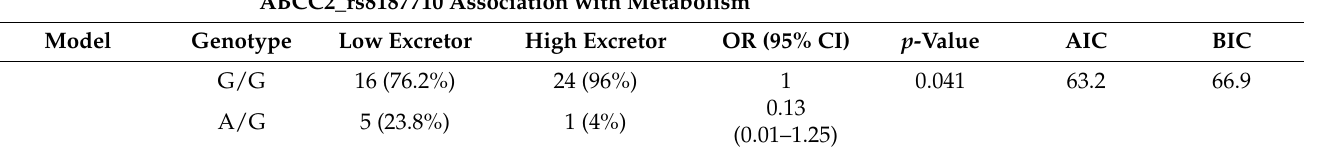
Figure 1. Total phase II flavanone metabolite concentrations in urine depending on genotypes of ABCC2_rs8187710 polymorphism. Bars in the box show the first quartile, the third quartile and median and whisker charts represent the minimum to maximum values. Table 4. Analysis of association of ABCC2_rs8187710 polymorphism with the excretion of phase II flavanone metabolites in urine of studied volunteers after single dose orange juice. ABCC2_rs8187710 Association with Metabolism